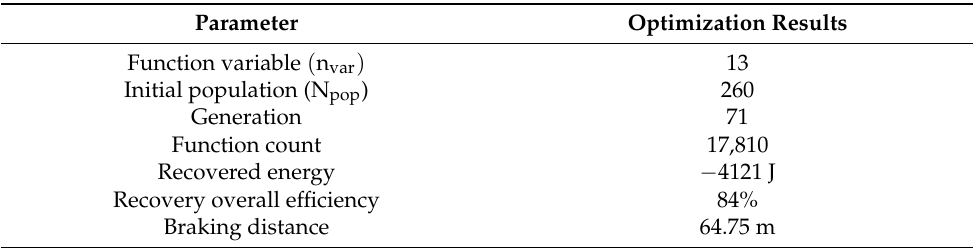
Table 2. Regenerative braking-torque optimization results.